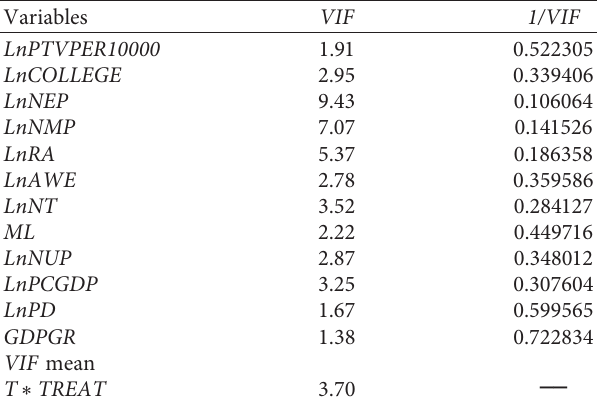
Table 4: Multicollineraity analysis results. Table 5: Average impact of ride-hailing services on private car use in urban